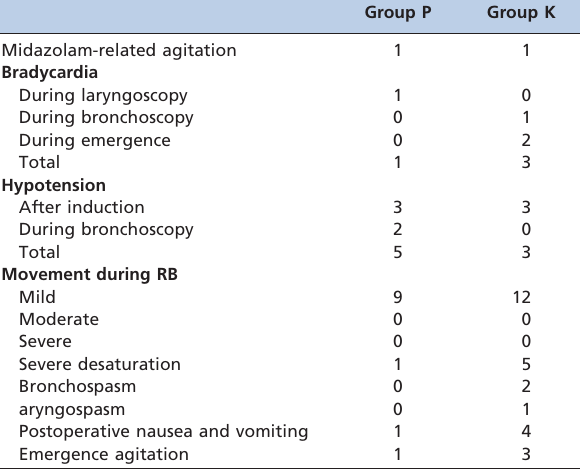
Table 5 - Adverse events.